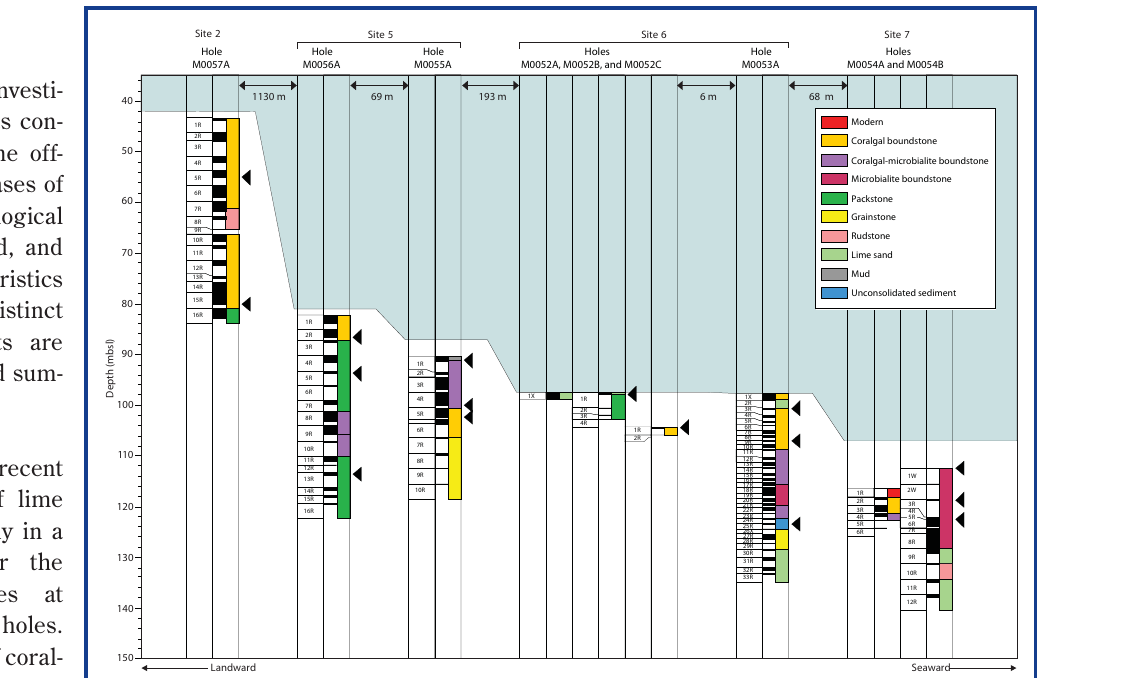
Figure 7. Lithostratigraphic summary of holes on the Transect NOG-01 (Sites from landward to seaward; M0057A, M0056A, M0055A, M0052A, M0052B, M0052C, M0053A, M0054A, and